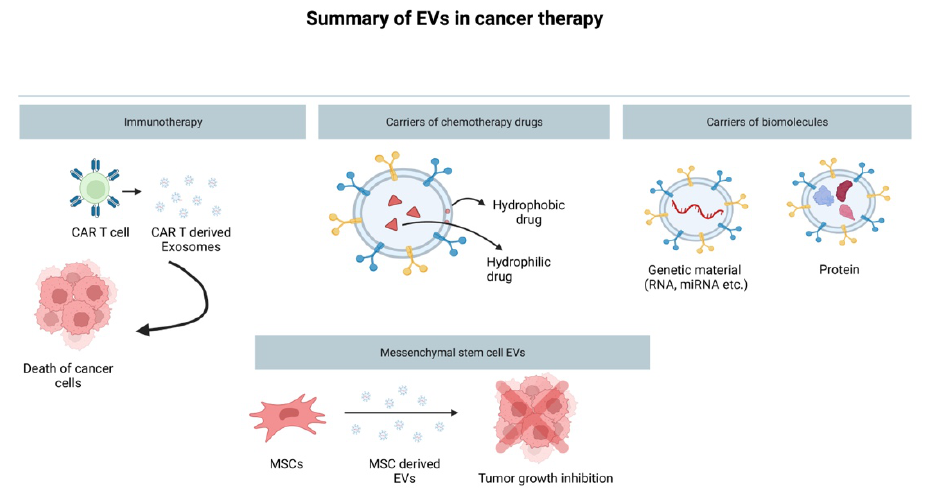
Figure 3. Schematic illustration summarizing the use of EVs in medicine as drug delivery systems. EVs can be used in immunotherapy, such as exosomes derived from CAR-T cells, can be effective at promoting cell death via immune defense activation [63]. EVs can also be loaded with chemotherapy drugs (both hydrophobic and hydrophilic), and can safely deliver the drug to the cancer cells intact due their lipid bilayer in which the drug is enclosed. Moreover, EVs can be loaded with biomolecules such as antitumorigenic miRNAs, long noncoding RNAs, mRNAs, and proteins (e.g., tumor suppressors). Finally, EVs derived from mesenchymal stem cells can be utilized as an anticancer treatment themselves due to their ability to suppress tumor growth.